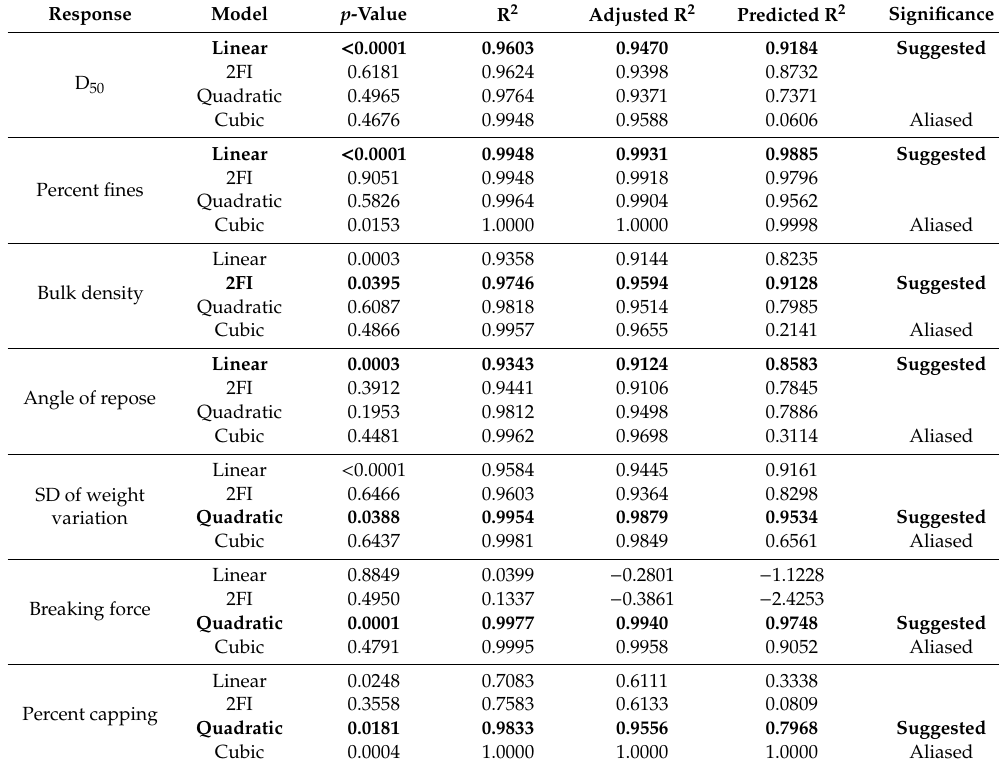
Table 5. Model summary statistics and model selection criteria for dependent